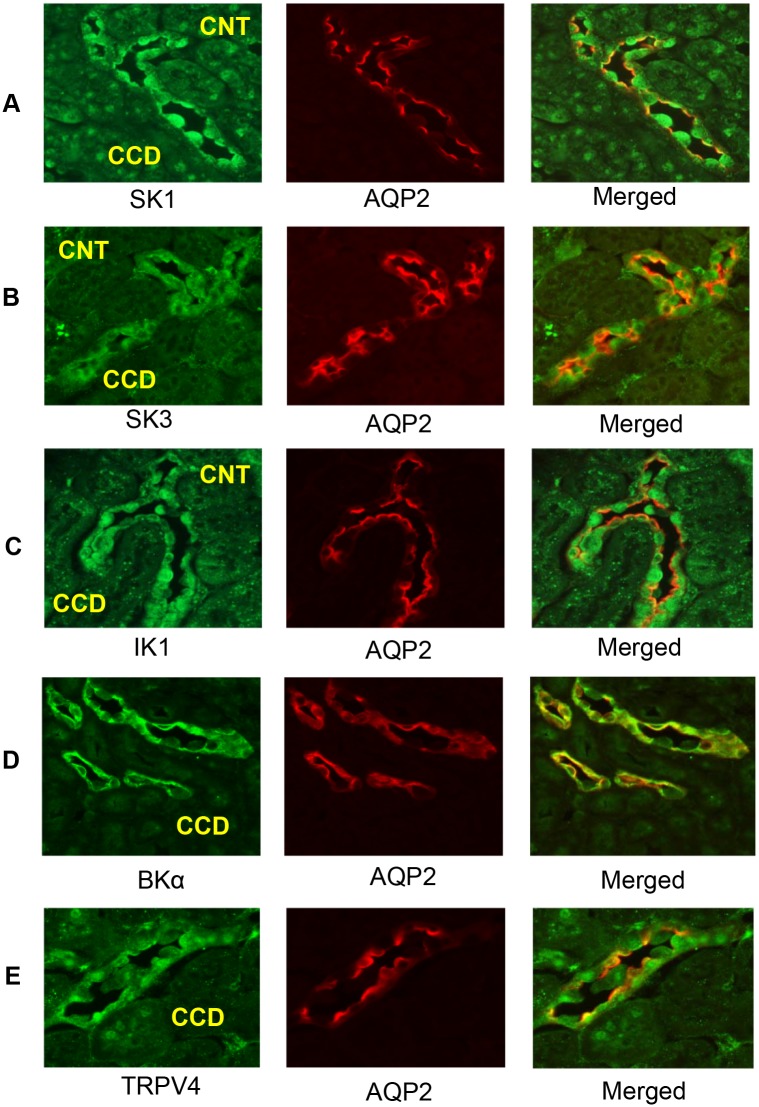
Immunocytochemistry fluorescence images showing results of staining for ion channels in mouse kidney cortical sections at low magnification.Results show staining for the ion channel of interest and for AQP2 (Red, 594 nM), a marker of CNT and CCD in the cortex. A bifurcation of AQP2-positive tubules was used to identify CNT segments (above the bifurcation) and CCD segments (single tubule below the bifurcation). A. SK1 staining of tubule segments (green, 488 nm) shows strong staining of many cells along both the CNT and CCD (SK1, labels CNT and CCD). Merged images with AQP2 staining verify the CNT and CCD sites of localization. B. SK3 staining of tubule segments (green, 488 nm) shows prominent staining of most cells along both the CNT and CCD (SK3, labels CNT and CCD). Merged images with AQP2 verify the CNT and CCD sites of localization. C. IK1 staining (red, 594 nm) is strong in most cells of both the CNT and CCD (IK1, labels CNT and CCD) as verified in the Merged image. D. BKα staining (green, 488 nm) is prominent in most cells of both the CCD (BKα, CCD) and along the CNT (data not shown) as verified in the Merged images. E. TRPV4 staining (green, 488 nm) is apparent in most cells of the CCD (TRPV4, CCD) and in the CNT (data not shown) as verified in the Merged images. All fluorescence images were obtained at 40x (oil) with a Zeiss Axioskop 40 microscope using a AxioCam MRm CCD camera.